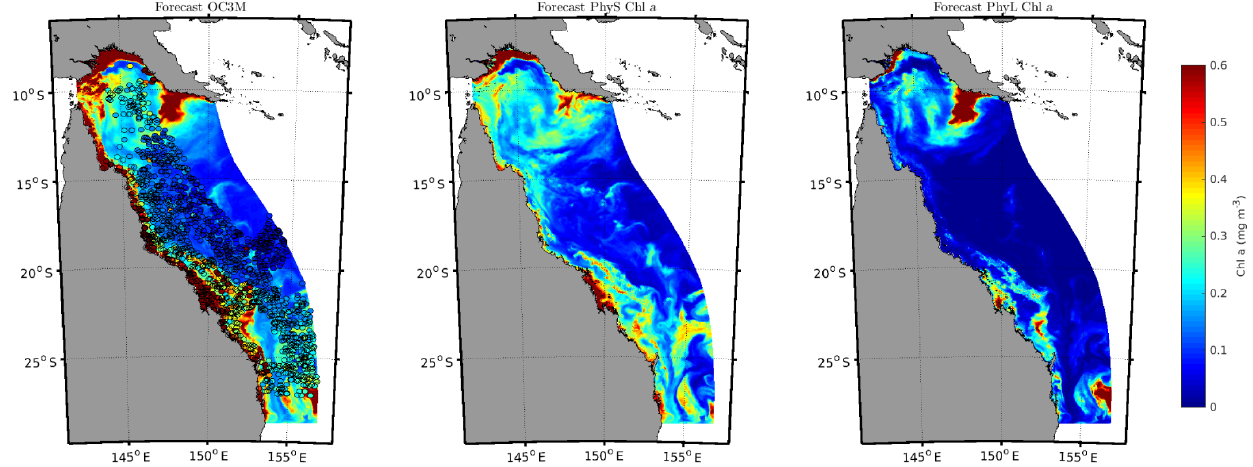
Figure 13. Simulated (forecast) OC3M (left) for cycle 22 (12th September 2013) of EXP4 with observations overlaid, surface small phyto-